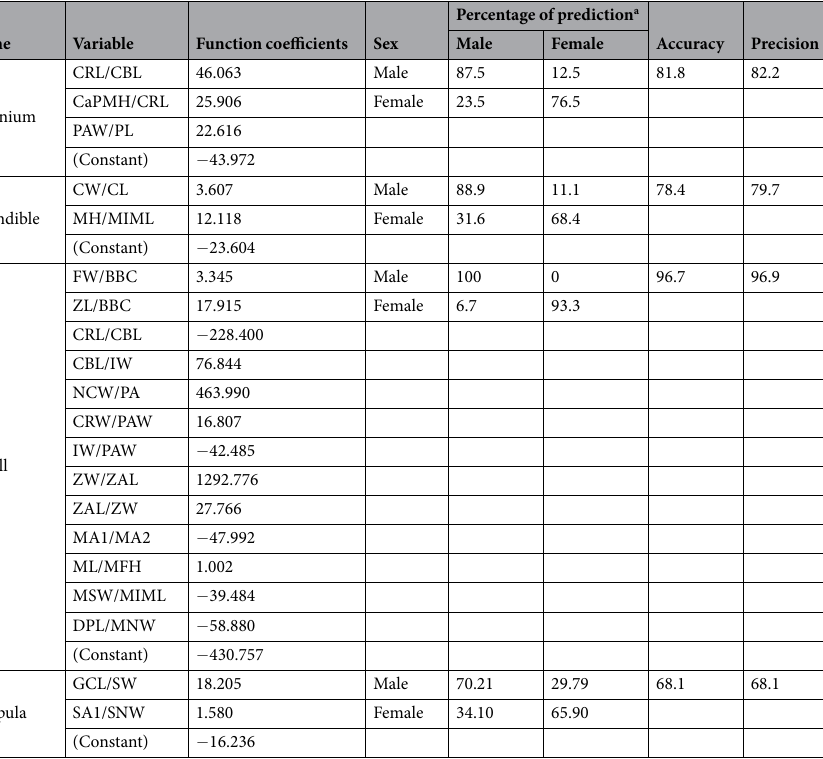
Table 5. Functions obtained from stepwise discriminant analysis based on the morphometrics of the cranium, mandible, skull and scapula and their classification results for assigning gender. a Cross-validation is done only for those cases in the analysis. In cross-validation, each case is classified by the functions derived from all cases other than that